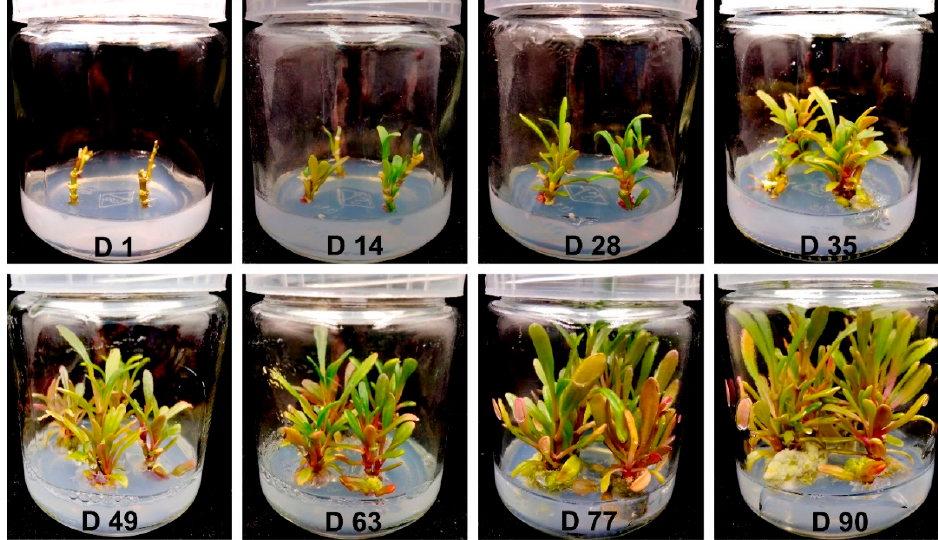
Figure 3. Axillary shoots induced from nodal explants of S. portulacastrum cultured on MS medium supplemented with 1.0 mg L − 1 ZT and 0.3 mg L − 1 NAA from day one (D 1) to day 90 (D 90). Table 2. Effect of different concentrations of ZT and NAA on induction of axillary shoots from nodal explants of S. portulacastrum cultured on 20 shoot induction media. Media